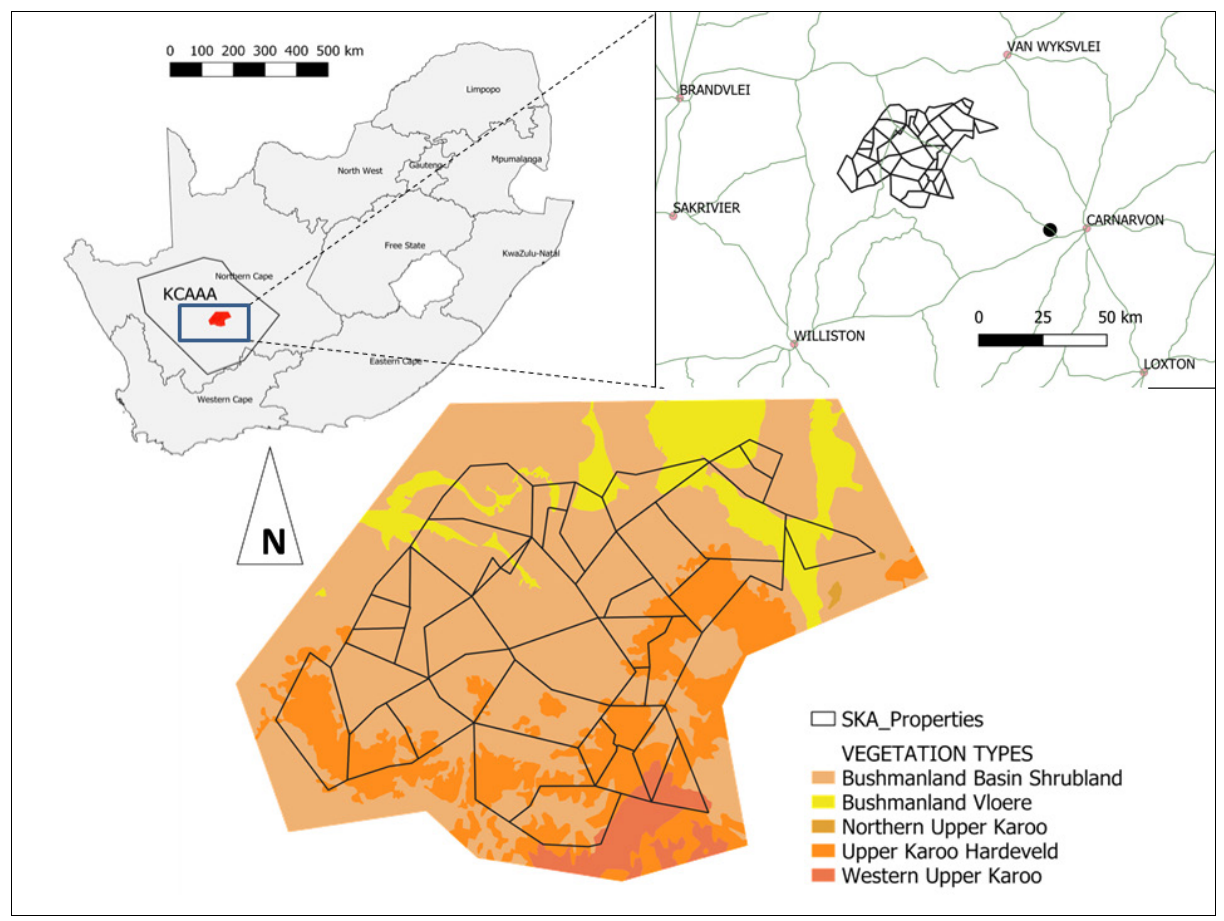
Figure 1: Vegetation units 16 in the Square Kilometre Array (SKA) area. National Research Foundation property boundaries are indicated. The outer polygon is a 5–10 km buffer applied when mapping biophysical features of interest for comparing contrasting land